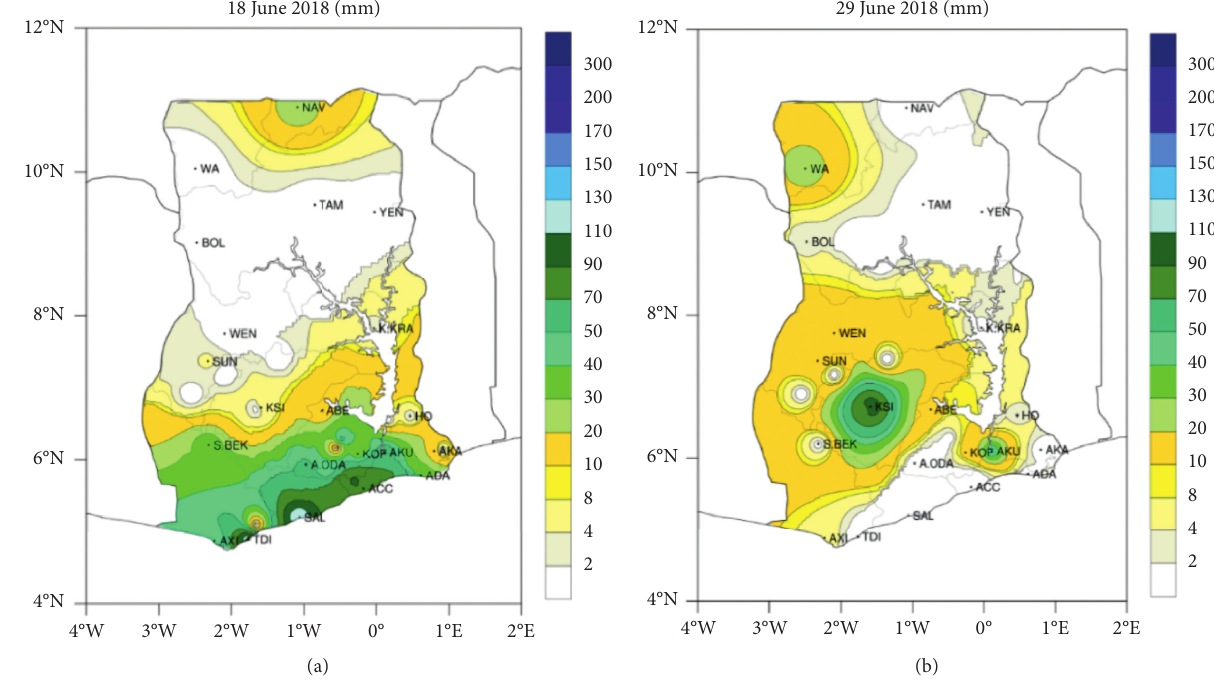
Figure 4: Distribution of rainfall (mm). (a) Case A and (b) case B.